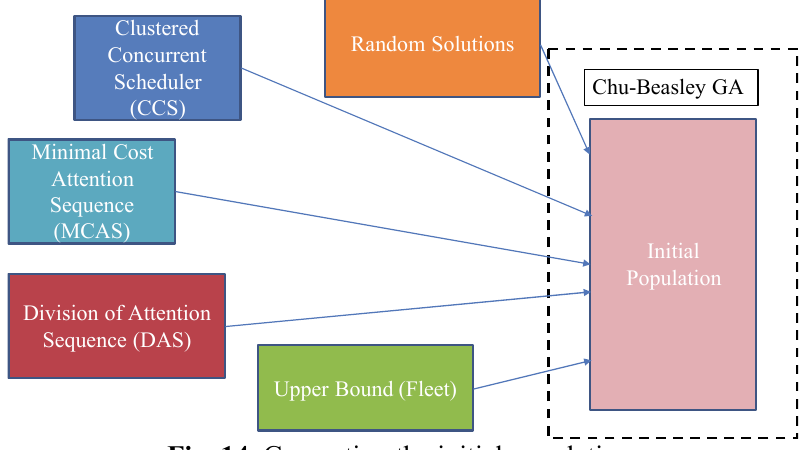
Fig. 14. Generating the initial